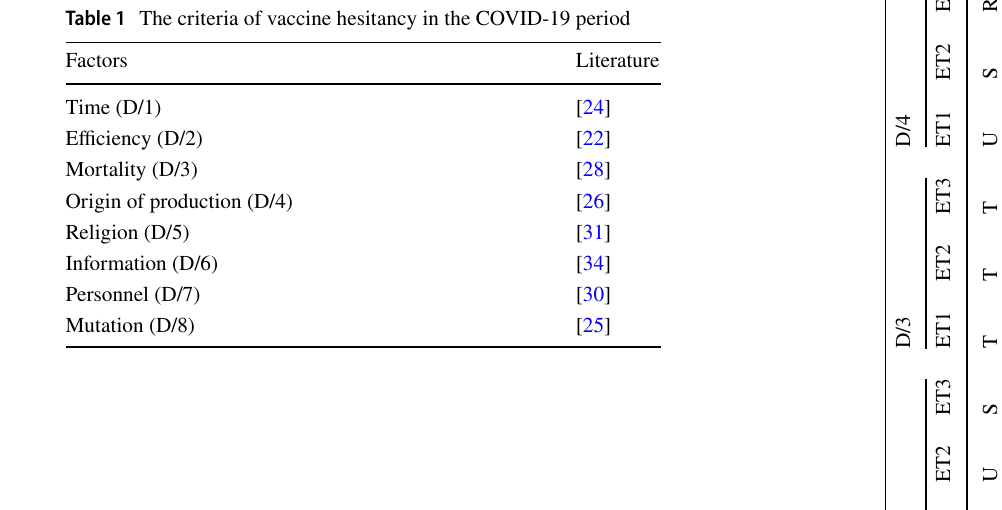
Table 2 Linguistic scales, membership, and non-membership degrees Linguistic scales for